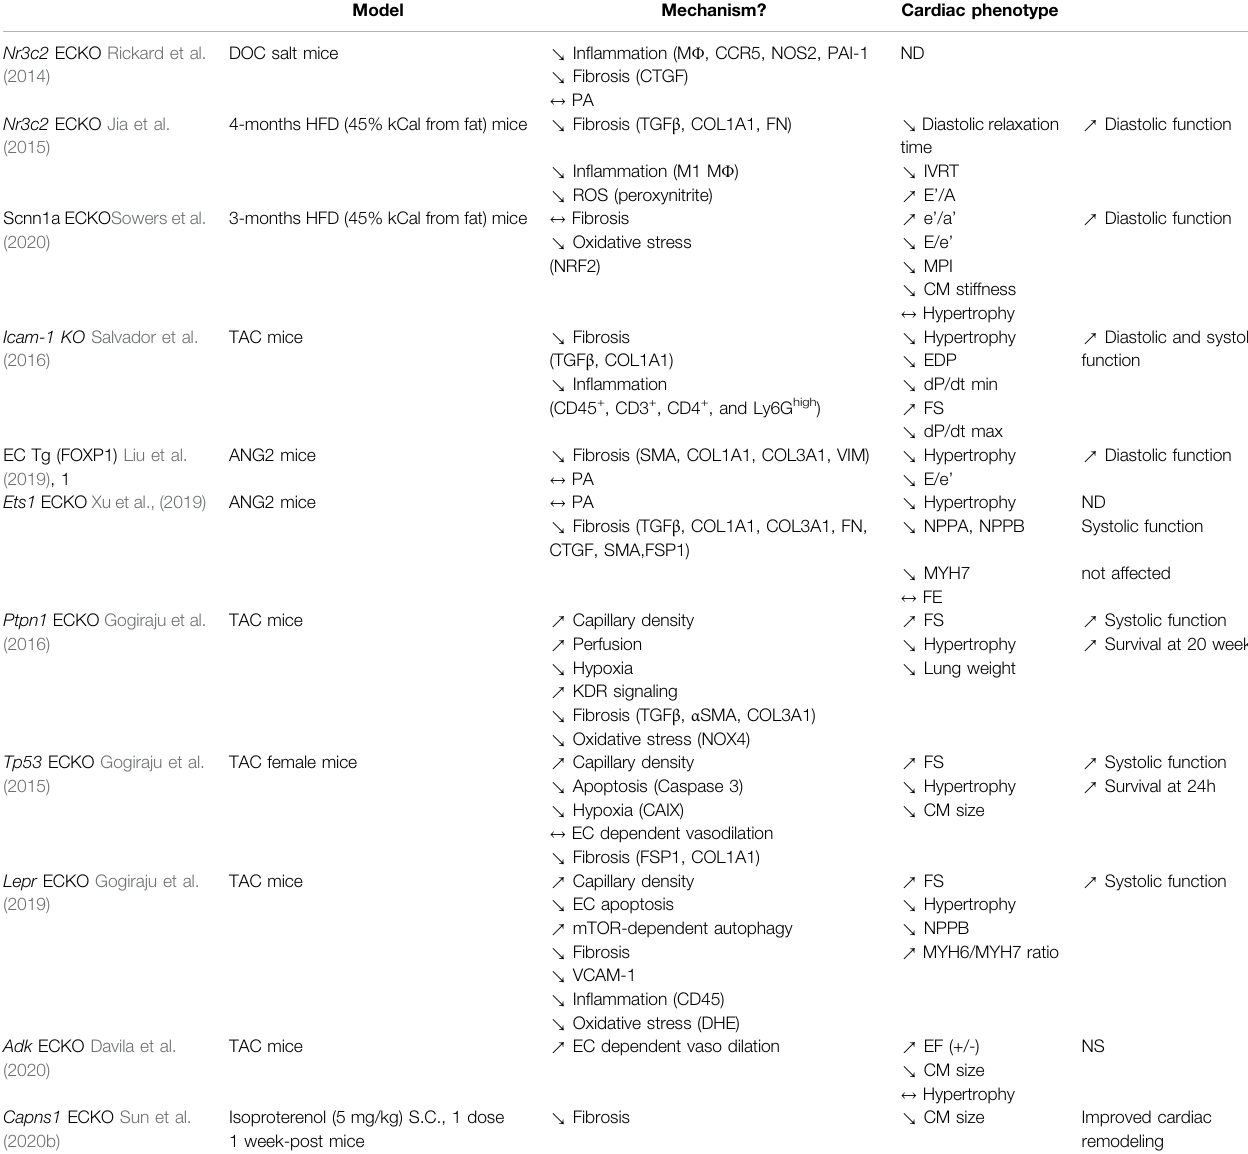
TABLE 5 | Genetic modi fi cations of EC properties that protect from developing cardiac